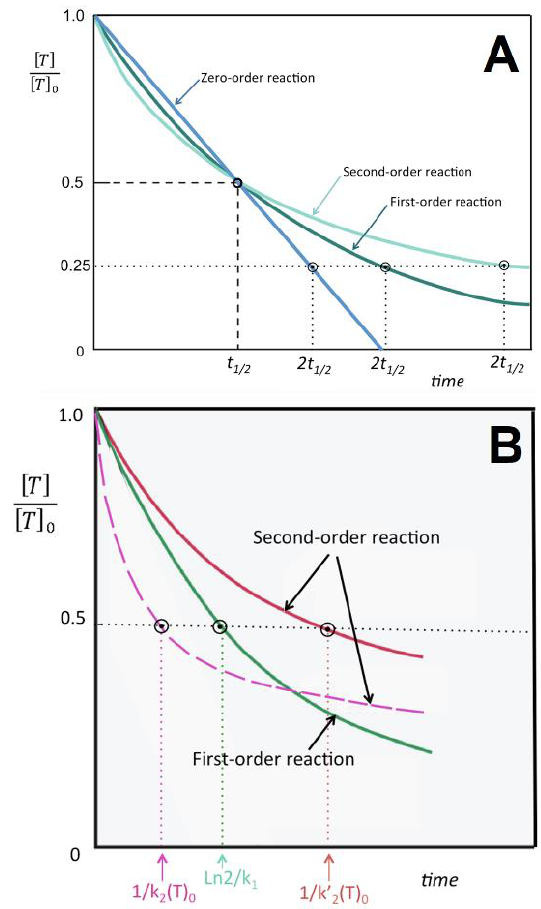
Figure 7. Practical consequences of zero-, first- and second-order reactions in nanoreactors. ( A ) Comparison of reactions for which the first half-time is the same; ( B ) Comparison of first- and second-order reactions with k II > k’ II .